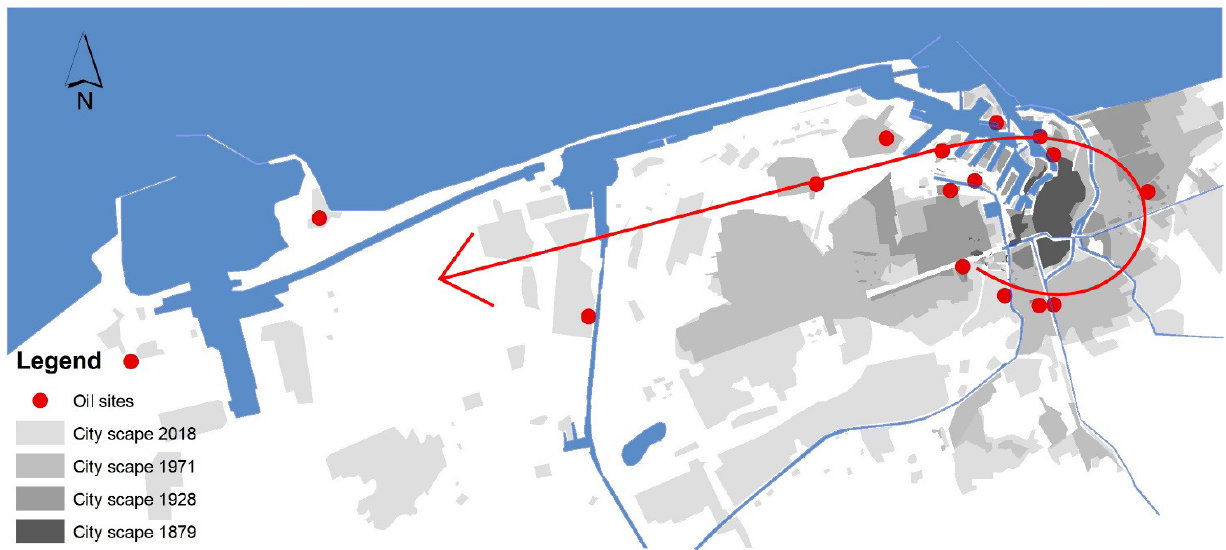
Figure 3. Map of Dunkirk showing the location of oil sites known and discovered during the research in parallel with the urban expansion of the city. The arrow illustrates the settlements through time of oil sites, from the periphery of the city towards a dedicated port area to the west. Source: Stephan Hauser using ArcGIS and archival maps of Dunkirk from